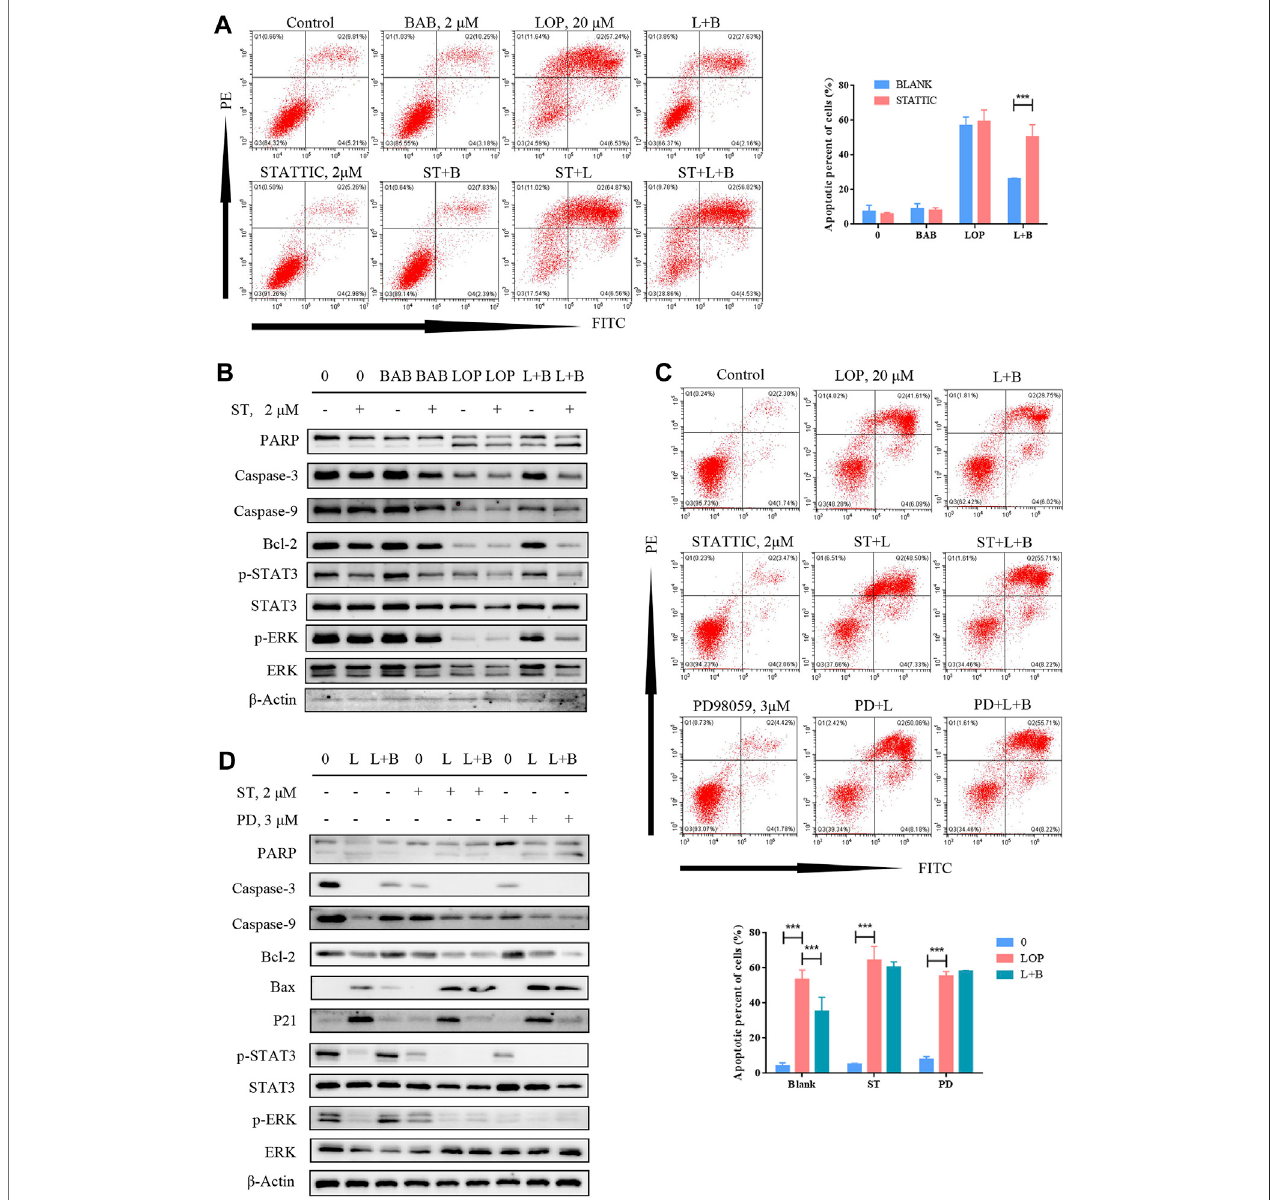
FIGURE 10 | BAB can reverse lop induced interstitial cells of Cajal apoptosis. (A) Flow cytometry was used to detect the apoptosis after STAT3 was inhibited and activated; (B) Western blot wasused todetect theapoptosis after STAT3 wasinhibited and activated; (C) fl ow cytometry wasused to detect theapoptosis after STAT3 or ERK was inhibited and activated; statistical analyses were shown below; (D) PD98059 and STATTIC were used to inhibit the activate of STAT3 and ERK. The expression of proteins associated with caspase pathway, cell proliferation and the activation of STAT3 and ERK were detected by WB.